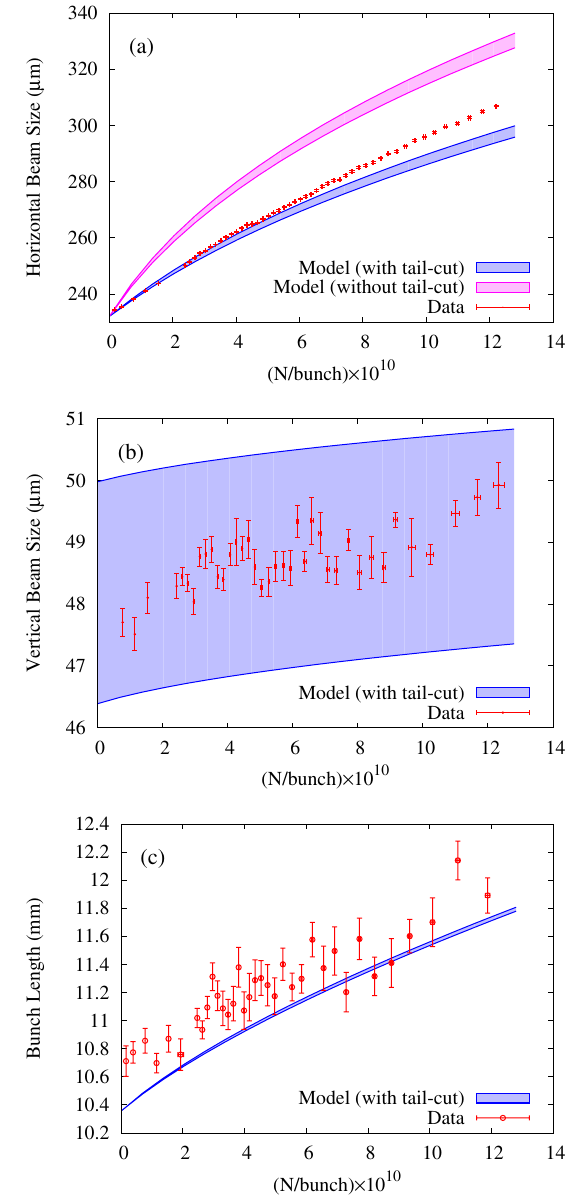
FIG. 11. (a) Horizontal, (b) vertical, and (c) longitudinal beam size versus current for e þ bunch with increased zero current vertical